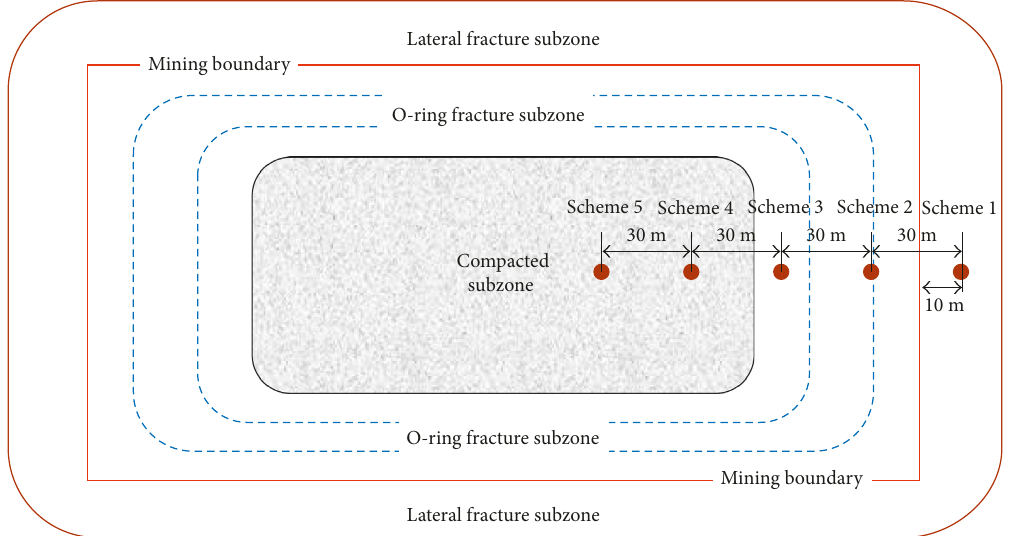
Figure 12: Layout schemes for the surface boreholes [15].